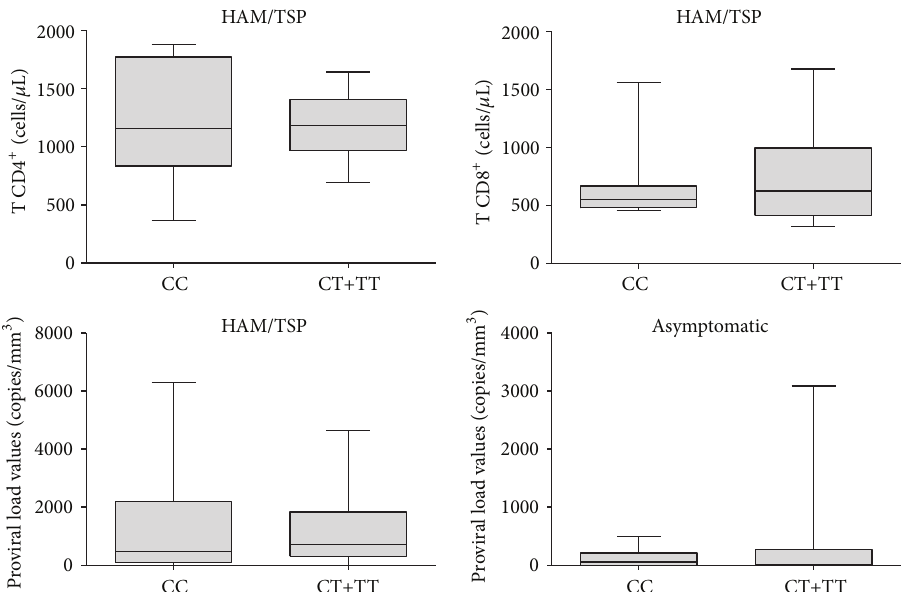
Figure 4: CD4 + /CD8 + T-cell and proviral load measurements in the HAM/TSP and asymptomatic groups according to the presence of the SNP